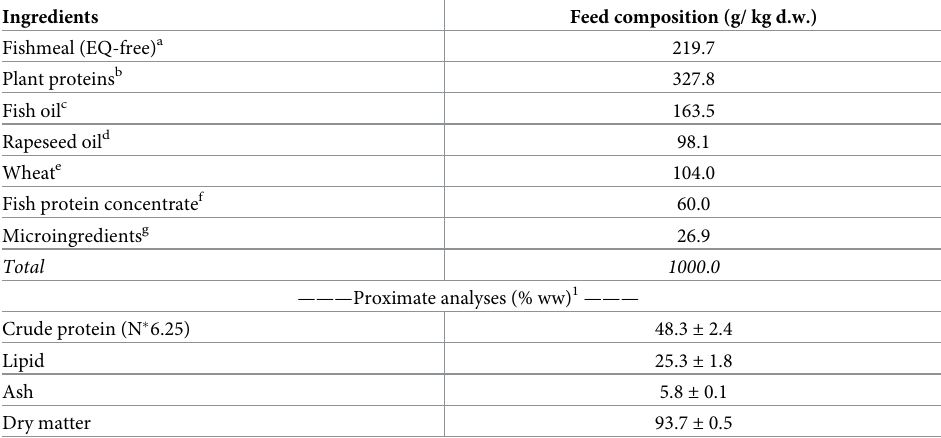
Table 1. Formulation and proximate composition of 5 mm fish feed pellets spiked with graded levels of ethoxy- quin (EQ) and fed to Atlantic salmon ( Salmo salar L.) for 90 days.